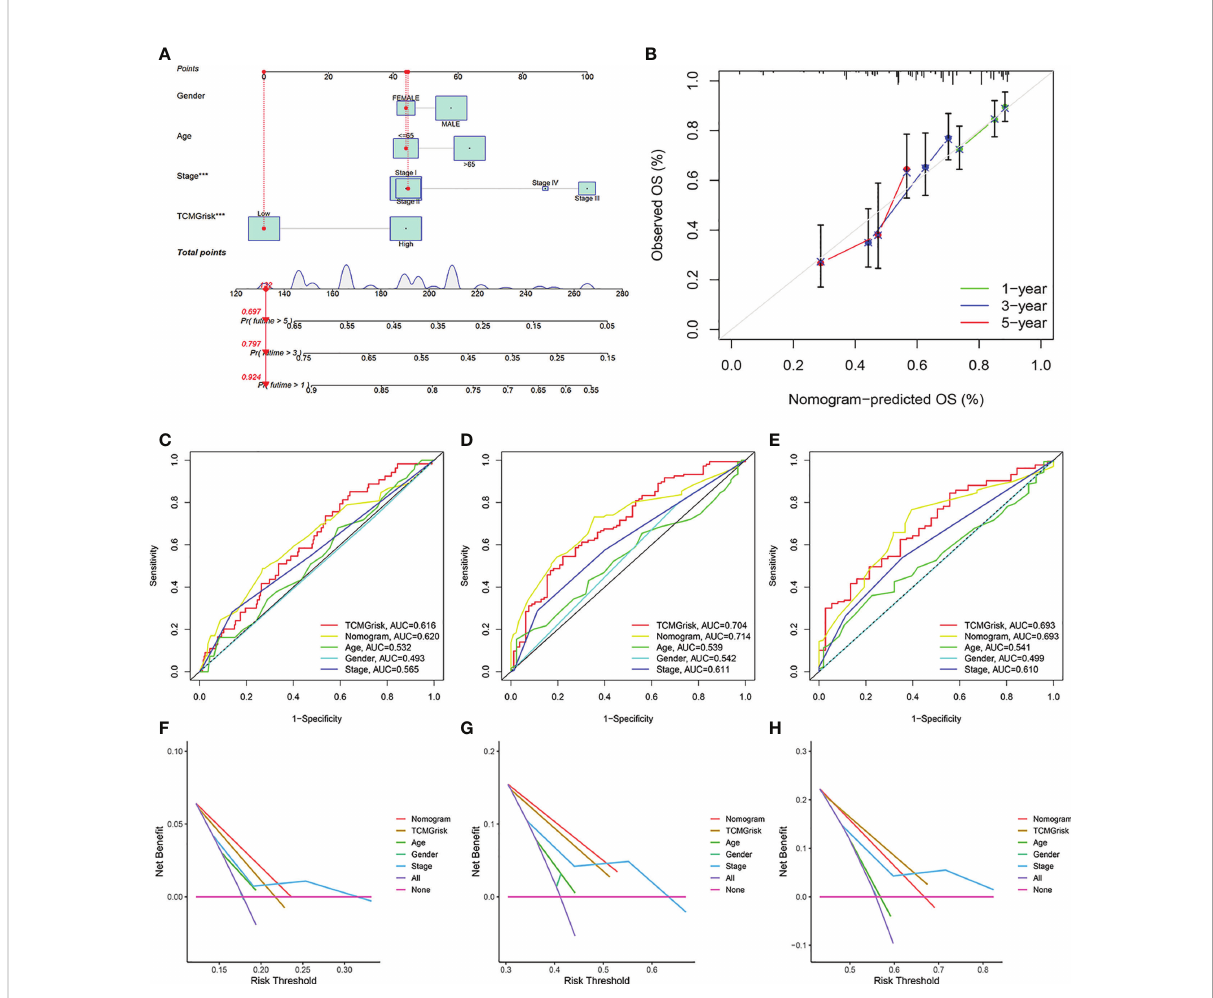
FIGURE 3 The establishment and validation of nomogram. (A) The construction of the nomogram. (B) Calibration curve for assess the agreement at 1-, 3- and 5-year OS. (C – E) The AUC of the nomograms compared for 1-, 3-, and 5-year OS, respective. (F – H) The DCA curves of the nomograms compared for 1-, 3-, and 5-year OS,